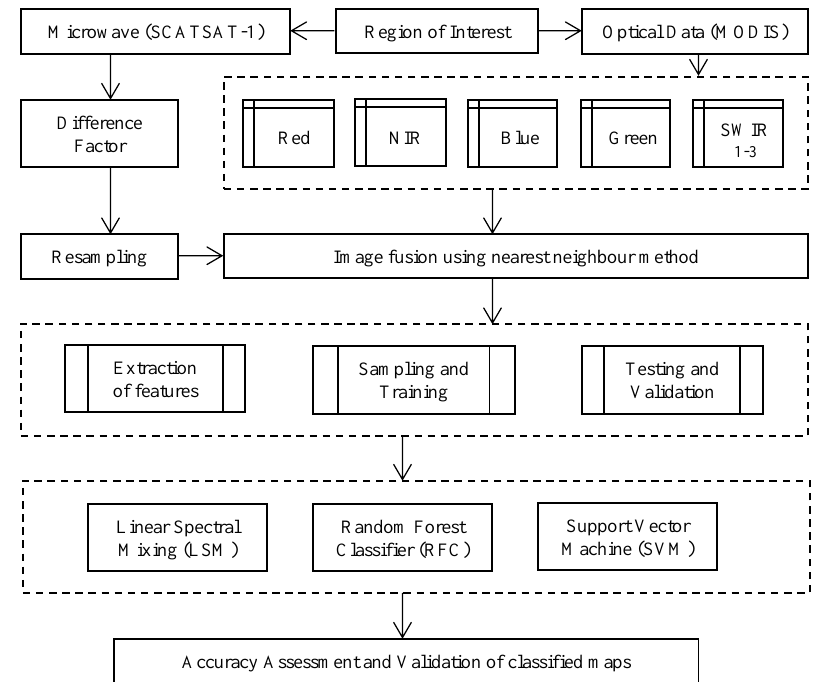
Fig. 2 Framework of methodology to combine the microwave and optical data, and perform the different classification algorithms and their accuracy